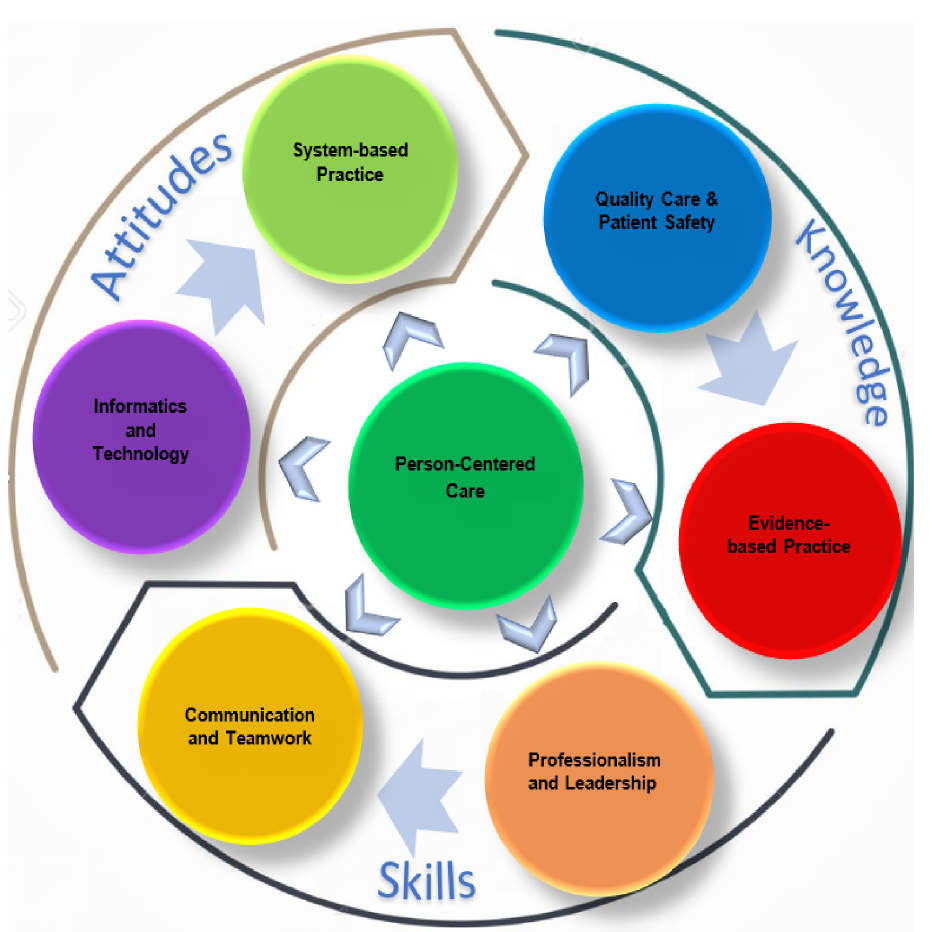
Figure 2. Core Competency Framework for Undergraduate Nursing Student.